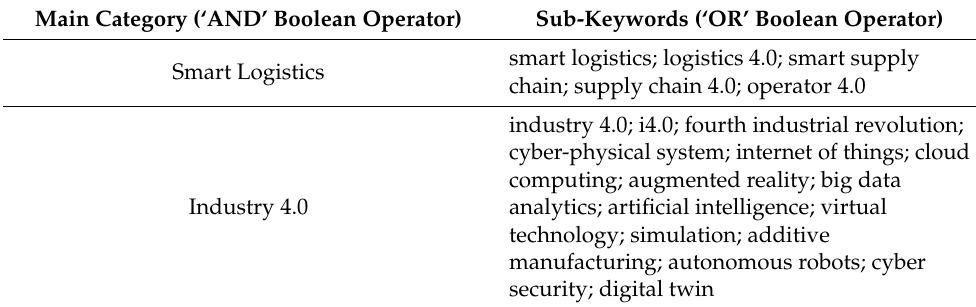
Table 1. Identified keywords for smart logistics in Industry 4.0. Main Category (‘AND’ Boolean